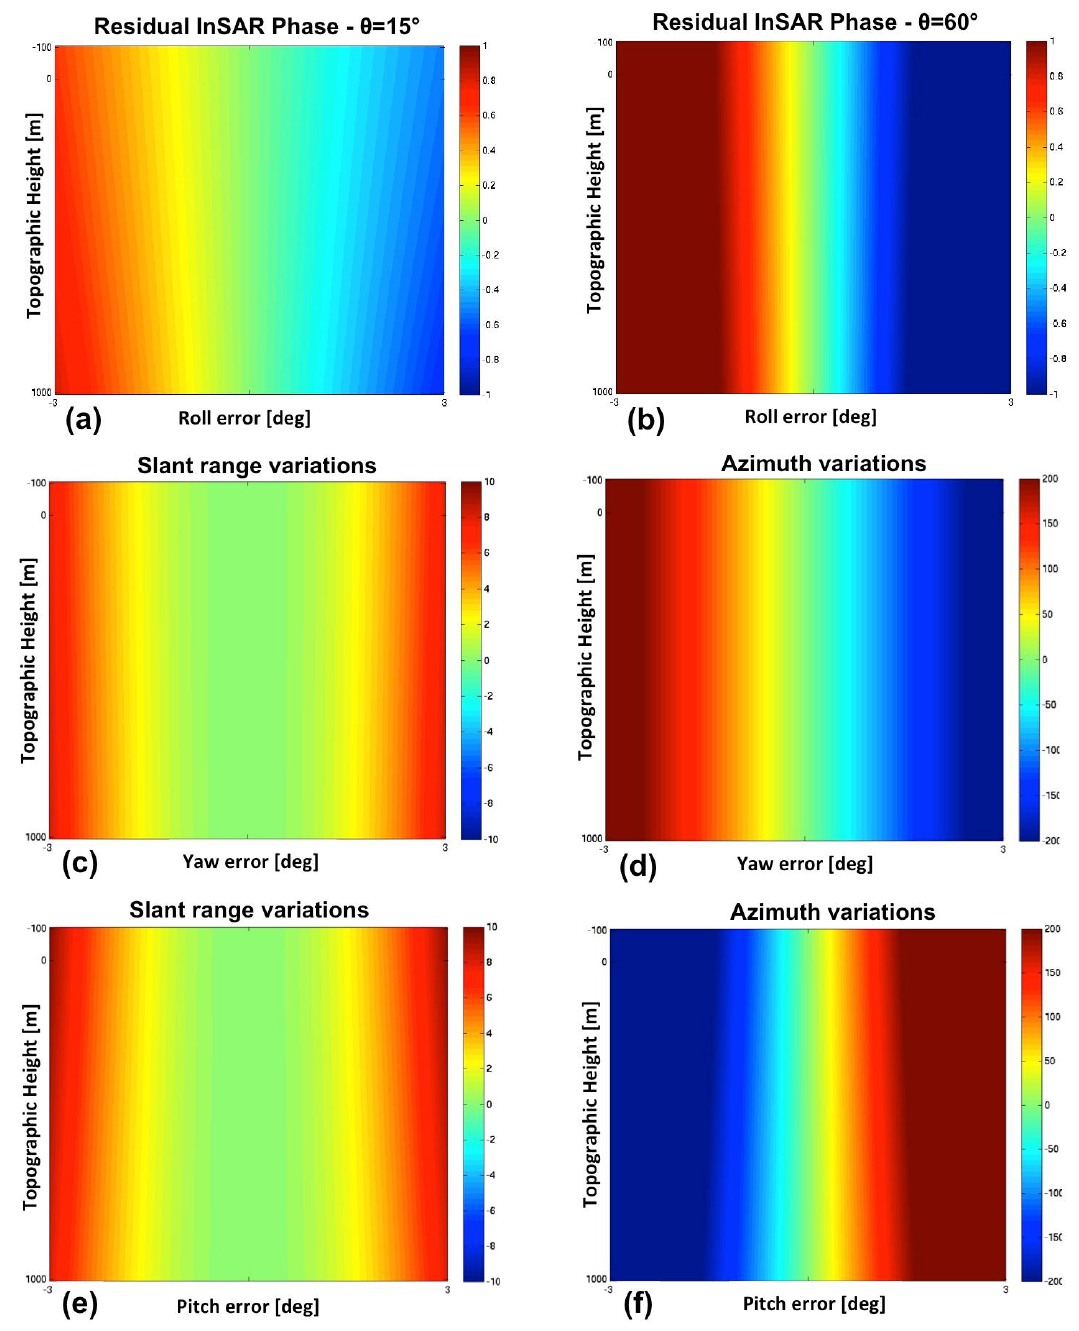
Figure 12. Subplots ( a , b ) show residual InSAR phase cycles evaluated for roll errors between −3° and 3°, and incident angles at near range ( a ) and far range ( b ). Subplots ( c – f ) show the misalignments in slant range and azimuth evaluated for yaw ( c , d ) and pitch errors ( e , f ) between −3° and 3°, assuming topographic heights ranging from −100 m to 1 km, and an incident angle at mid-range ( θ inc = 30°). For all the plots, the topographic height ranges from −100 m to 1